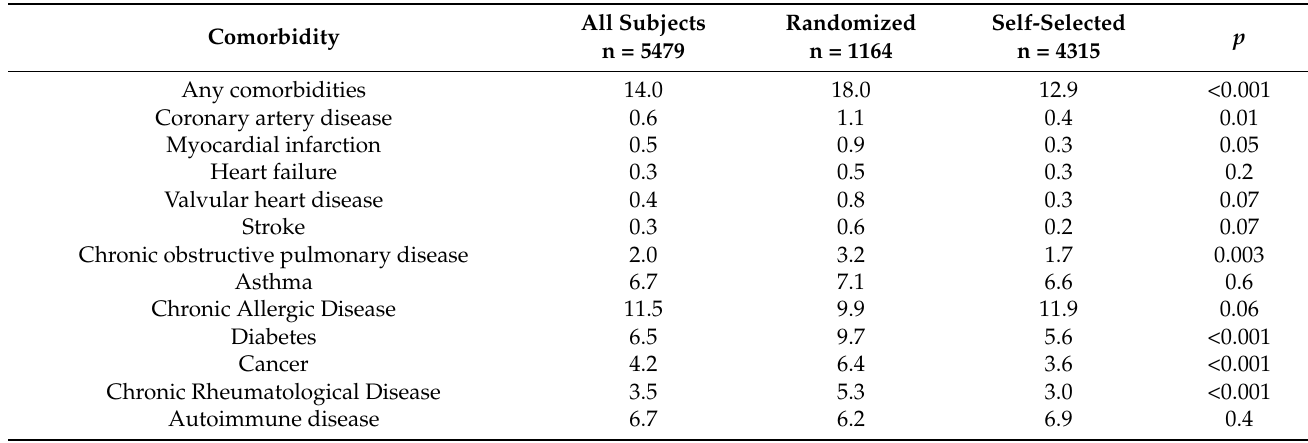
Table 2. The burden of comorbidities in the study group in the entire study group and depending on the recruitment mode